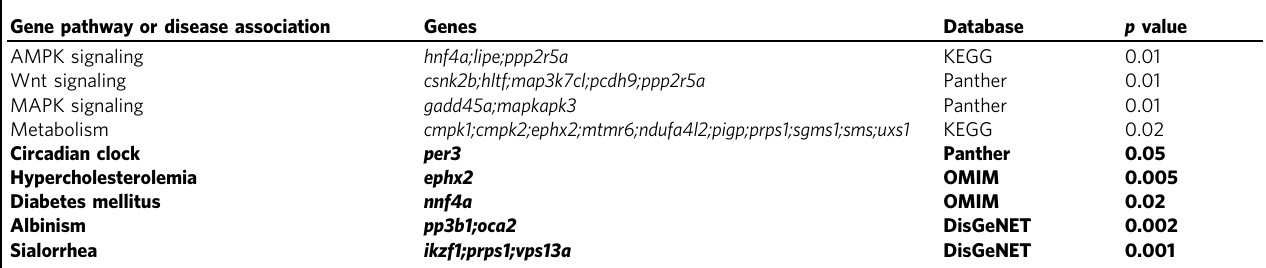
Bold text denotes signi fi cant tests for disease enrichment. For enrichment tests, we used a hypergeometric test, and the signi fi cance level was set at 0.05 and implemented the Benjamini and Hochberg multiple test adjustment 88 to control for false